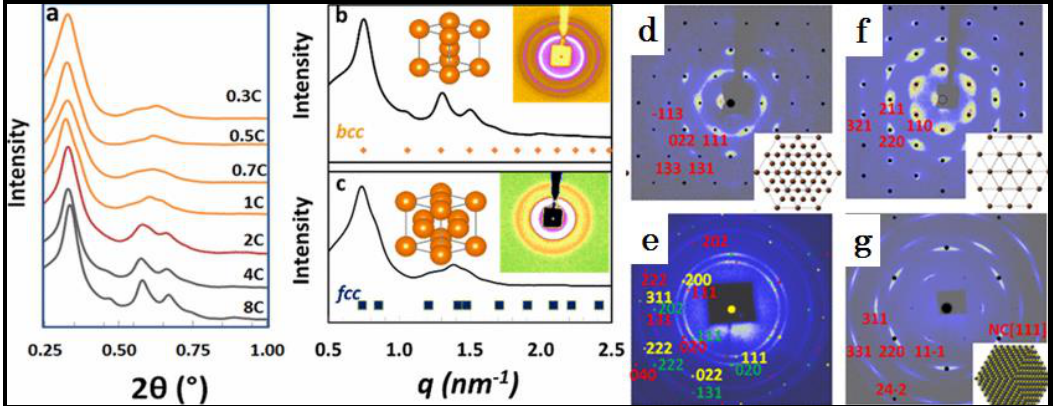
Figure 10. Controlled assembly of PbS NCs with intermediate ratios of surface truncations into single fcc and bcc superlattices, respectively. SAXS patterns showing ( a ) the concentration-dependent formation of 7.5 nm PbS NC superlattice into a mixture of or single ( b ) bcc and ( c ) fcc upon drop-casting of NC-suspending toluene; ( d ) SAXS and ( e ) WAXS images collected from a large single fcc supercrystal made upon slow evaporation of 6.7 nm PbS NC suspensions in a toluene solution with extra oleic acids; ( f ) SAXS and ( g ) WAXS images collected from a large single supercrystal obtained from an anti-solvent diffusion of isopropanol into 6.7 nm PbS NC-suspending toluene. Note: 1C = 17.5 mg/mL. Copyright of the American Chemical Society [46,55].